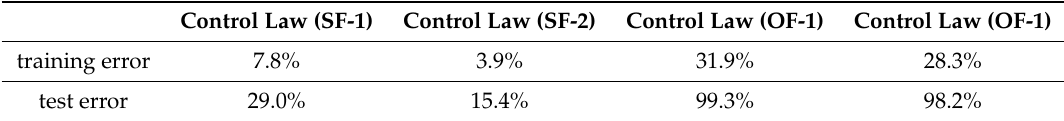
Table 4. Training and test errors of the four control laws.